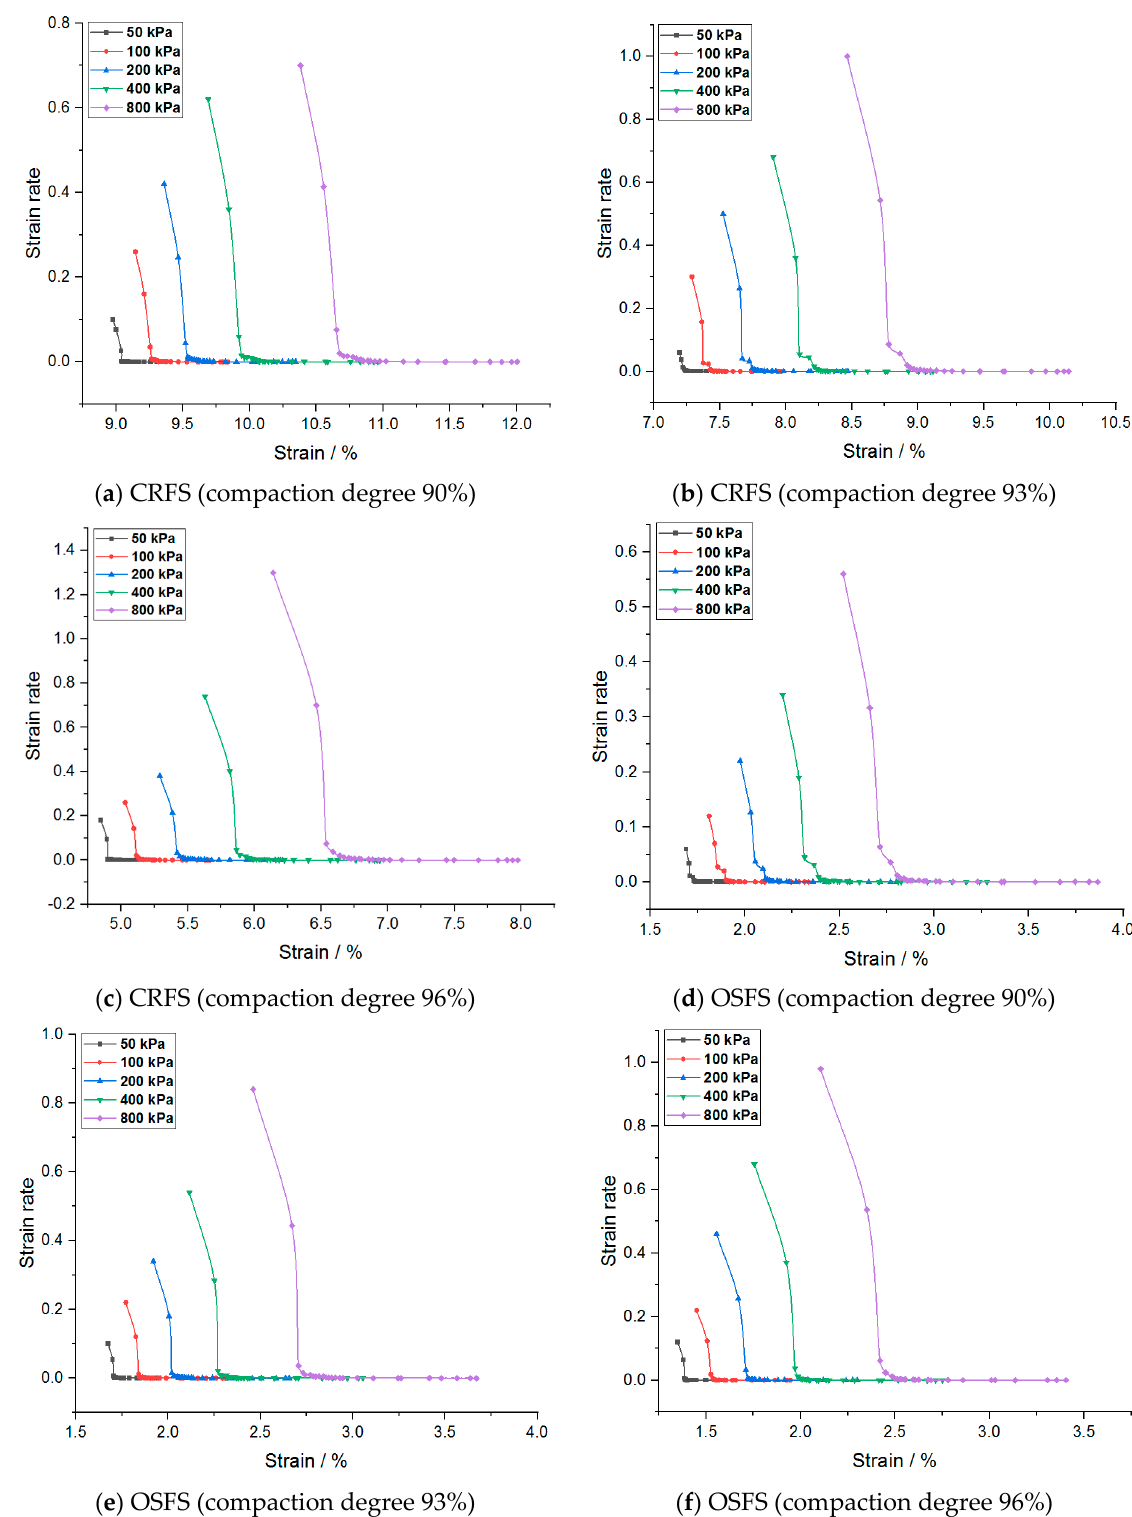
Figure 8. Strain rate–strain curves of modified soil with different compaction degrees. It can be seen from Figures 7 and 8 that the strain rate slows down gradually with the increase of strain and finally approaches zero. In addition, the initial strain rate increases with the increase of consolidation pressure, water content, and compaction degree. The strain rate of OSFS is less than that of CRFS, which is about 80% of the latter.